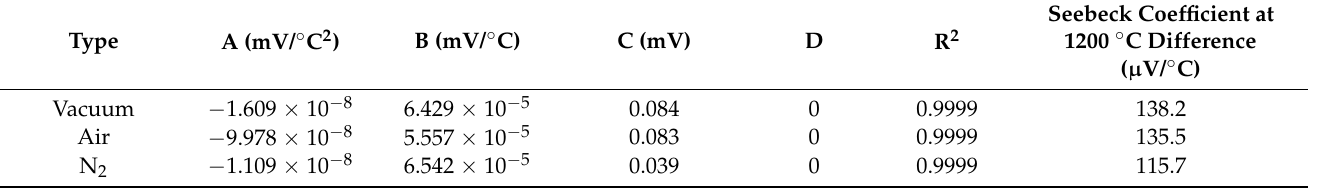
The output thermal voltage and the Seebeck coefficient of the overall sensor depend